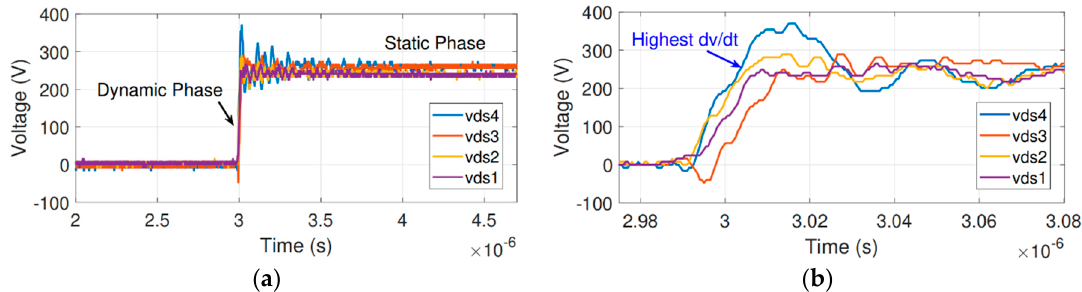
Figure 17. Voltage balancing after adding the proposed MSP ( a ) and its zoomed view ( b ); CASE 3.